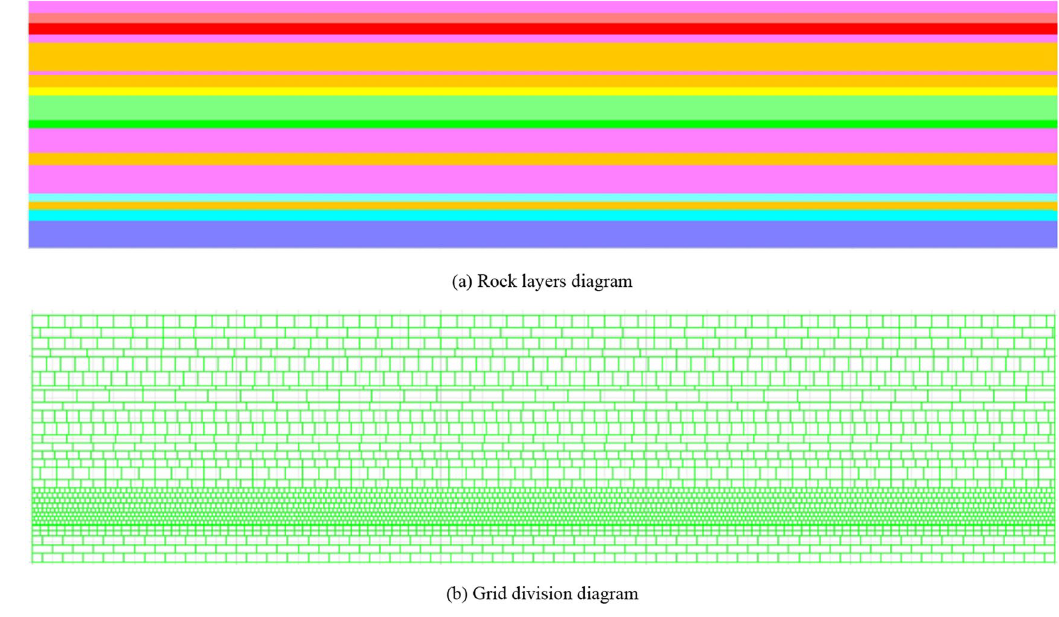
Figure 1. The model (UDEC 6.0).